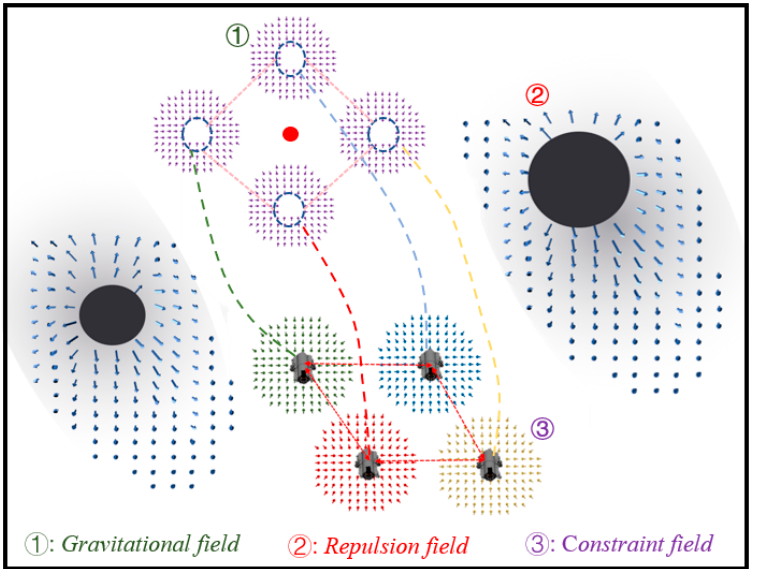
Figure 11. Schematic diagram of formation scheme based on improved artificial potential field and virtual structure.